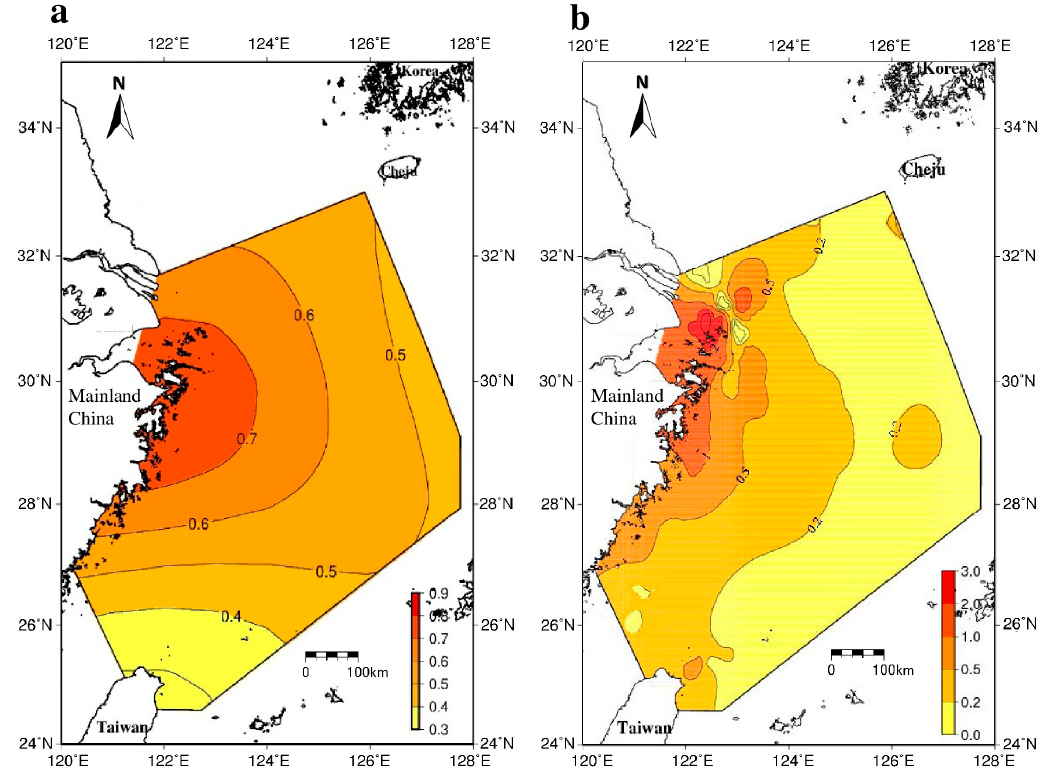
Figure 6. Sediment MARs (in cm/year) over April 2002–March 2015 from ( a ) GRACE and ( b ) sediment core measurements [4]. The EWH rate is equivalent to MAR (see Section 3.1).